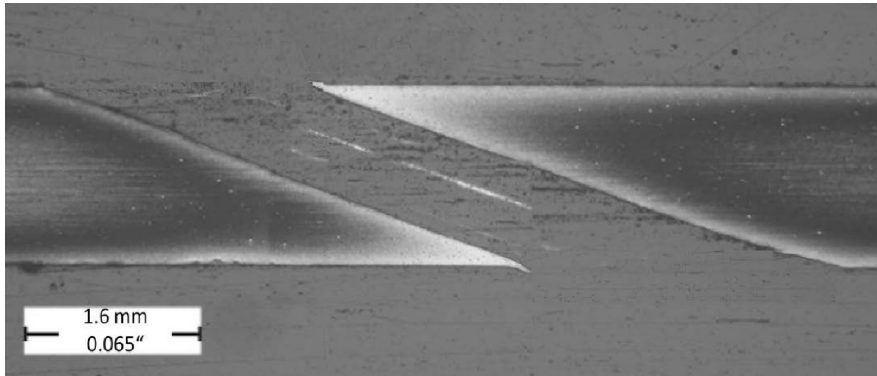
Figure 8. Longitudinal hole section (magnification 20x); sample group—3C (Table 2).